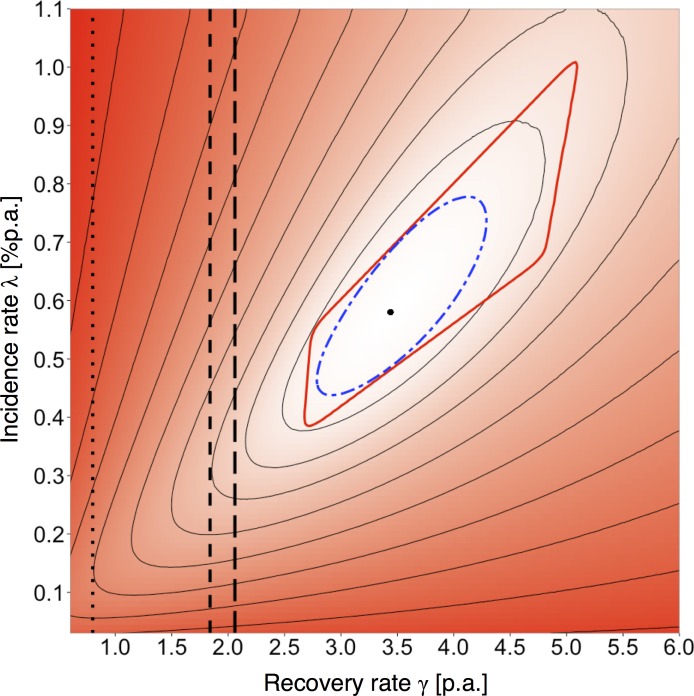
Recovery rate vs. incidence rate, maximum-likelihood estimate and plausible parameter range, Ugandan sex workers.Black dot: maximum-likelihood estimate (MLE) for the recovery rate (γ = 3.44p.a.) and the incidence rate (λlow = 58%p.a.); thin, black contours: equal likelihood; colored areas: white indicates maximum likelihood, red indicated low likelihood; thick, dashed, blue contour: 95% CI of the MLE; thick, red contour: parameter area where the model is consistent with the empirical data (α<0.05); vertical lines: estimates from London-student data; dotted: maximum-likelihood estimate (γ = 0.80p.a.); short-dashed: highest plausible estimate (γmax = 1.84p.a.); long-dashed: highest plausible with stable partnership assumption (γstable,max = 2.06p.a.).